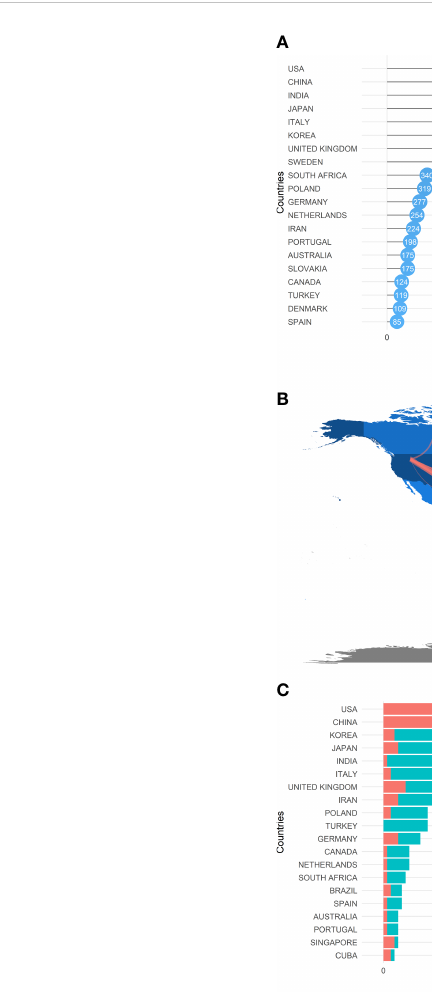
FIGURE 1 Central countries/regions of fi broblast-related DFUs research production and collaboration. The USA and China were the most two in fl uential and contributing countries in fi broblast-related DFUs research. (A) The top 20 countries/regions of fi broblast-related DFUs research with the highest number of publications. (B) Countries/Regions production and collaboration world map of fi broblast-related DFUs research. (C) Single-country and multi-country publications for the top 20 most productive